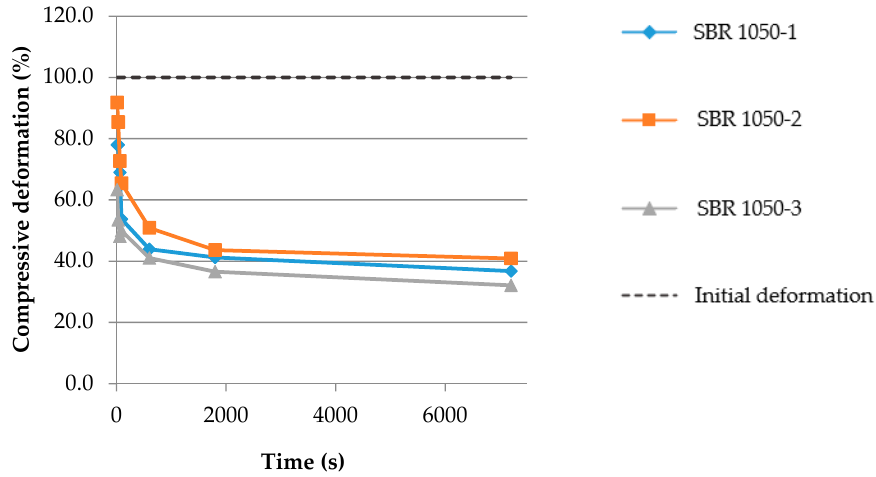
Figure 16. Samples’ deformation in the time domain, measured during relaxation after compression tests of the elastomeric material SBR 1050 at –30 °C; the deformation of 0% corresponds to the initial height of the sample before the test.